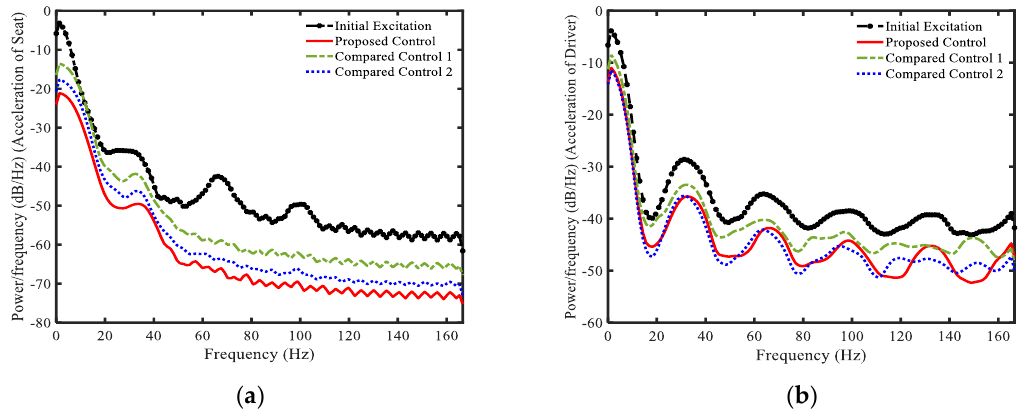
Figure 9. Experiment results of power spectral density: ( a ) acceleration of seat; and ( b ) acceleration of driver.